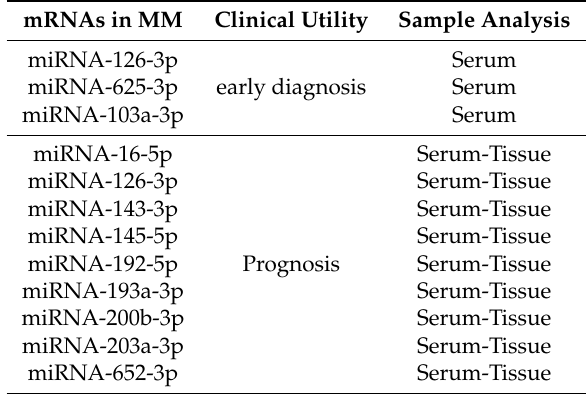
Table 2. Potential miRNA biomarkers for Malignant pleural mesothelioma